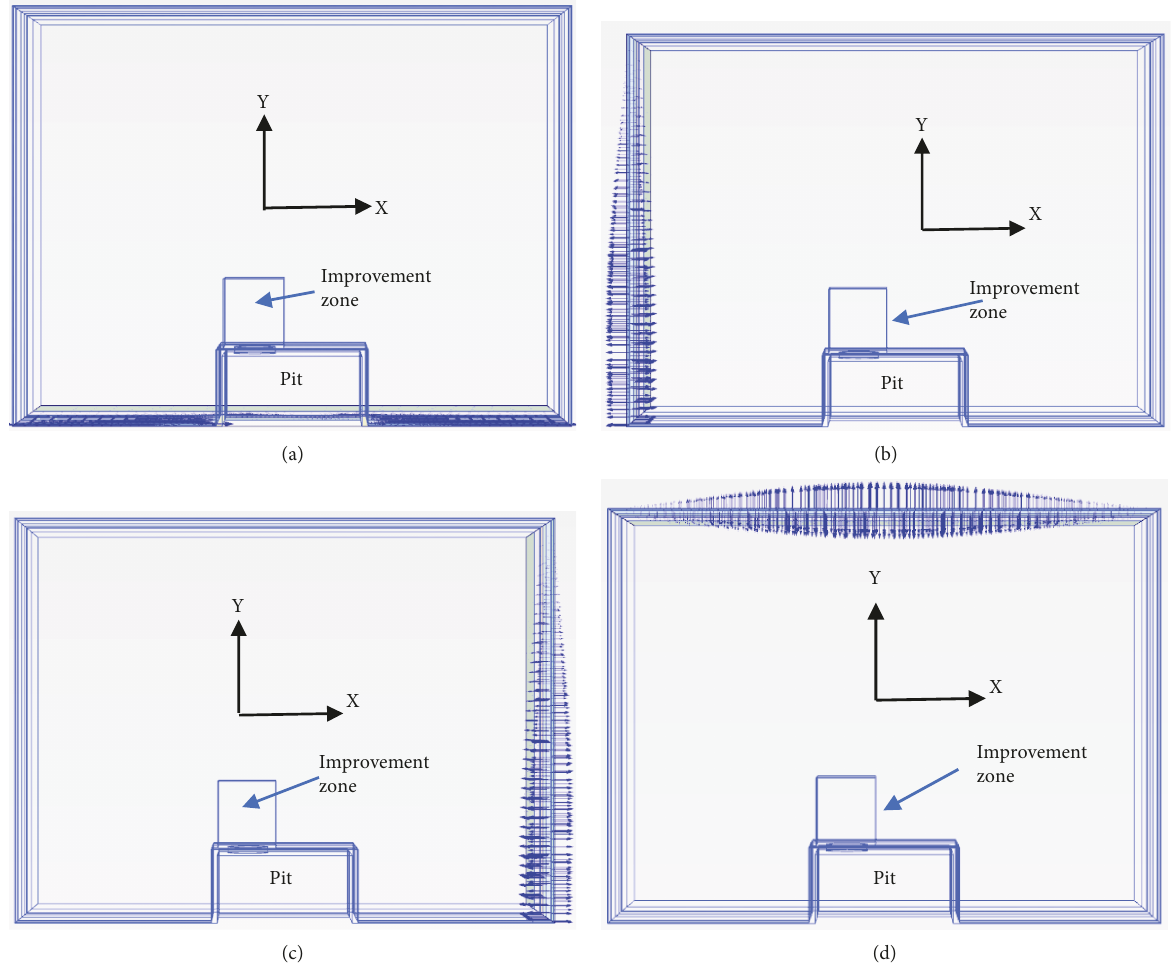
Figure 5: Boundaries conditions of water in the model (Plane view). (a) Y